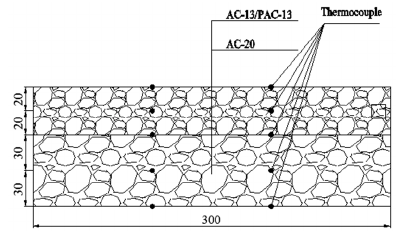
Figure 3. Location of thermocouple embedded.